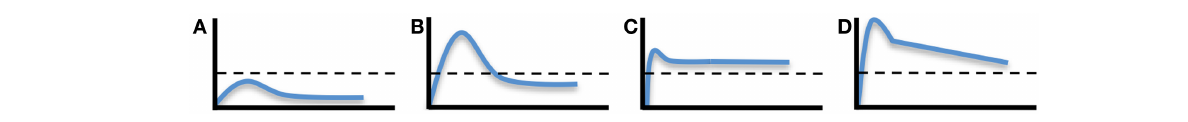
FIGURE 1 | Dynamics and duration of vaccine-induced immunity .The development of pathogen-specific immunity after vaccination can follow a number of different kinetic models. (A) Development of a measurable immune response can be determined, but if it does not reach above the protective threshold (indicated by the dashed line), then measurable immunity will note equate to protective immunity. Short-lived protective immunity (B) is common following primary immunization and is one of the reasons why most